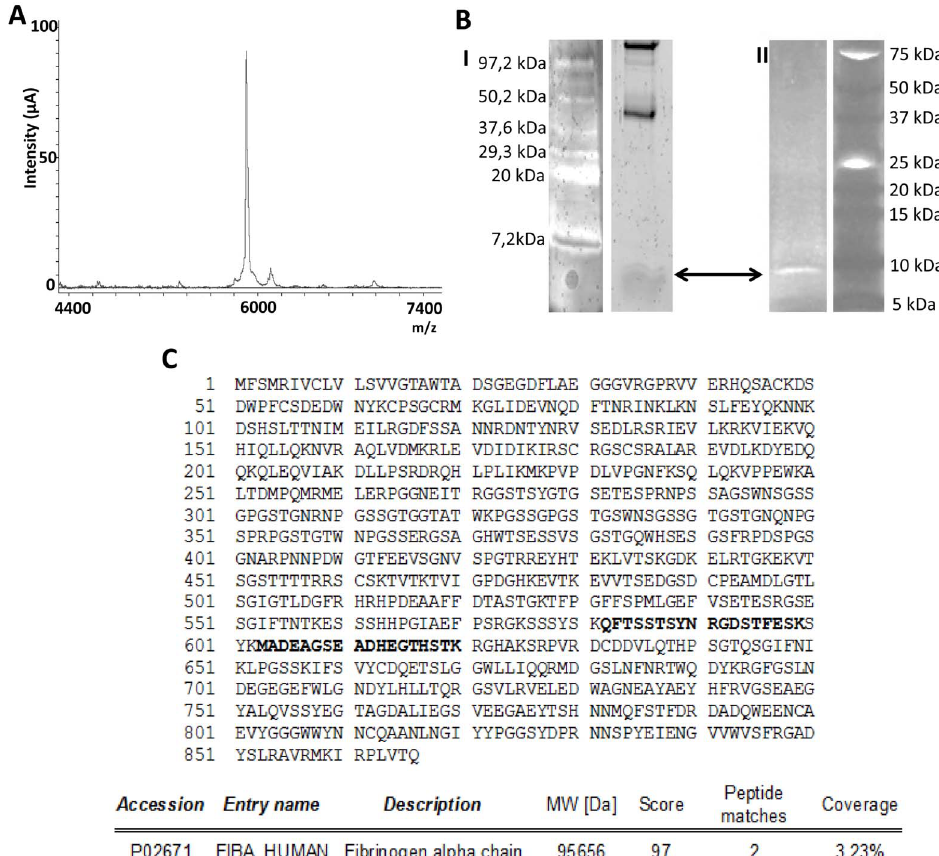
Figure 4. Isolation, separation and identification of the 5.9 kDa protein peak. A/ Spectra obtained by SELDI-TOF-MS showing the isolated protein peak after the purification process. B/ The isolated band indicated with arrows, after running two tris-tricine gels, one stained with sypro (I) and the other with oriole (II) staining. C/ Fragment of the Fibrinogen a -Chain identified as the differential protein peak by the amino acid sequencing. The two sequences identified are shown in bold.